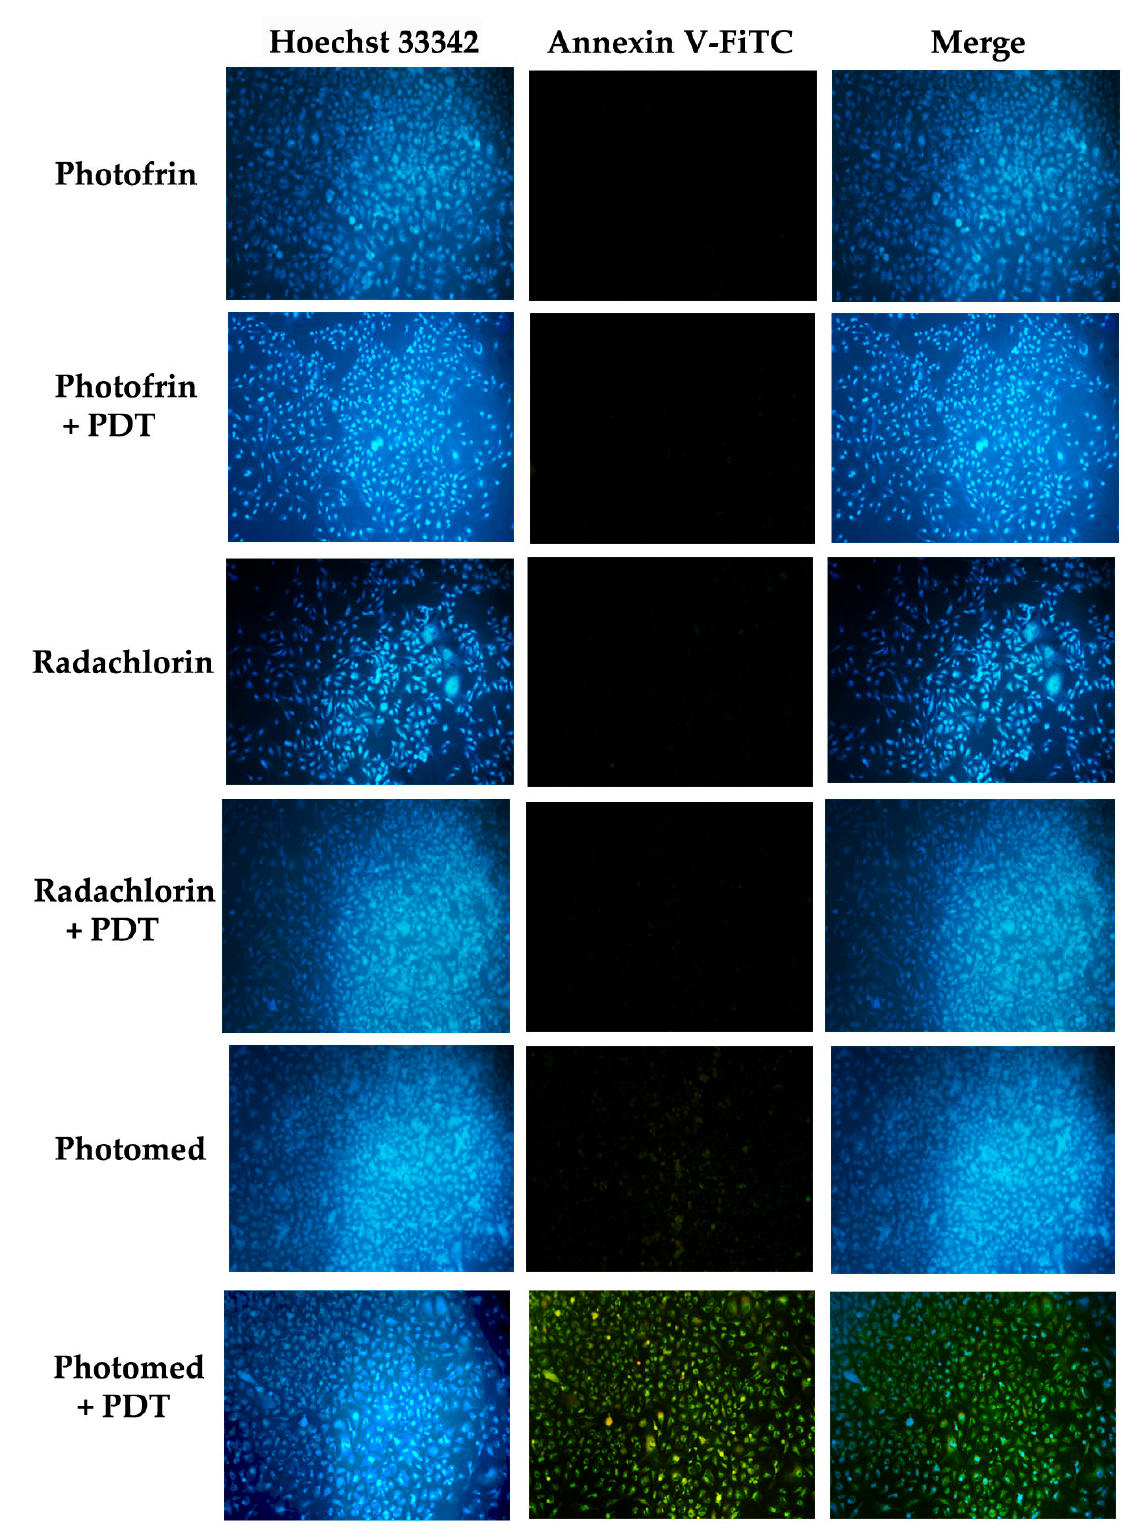
Figure 5. Fluorescence microscope analysis of apoptotic cells induced by PDT. Amounts of 0.5 µ M of Photofrin, Radachlorin and Photomed were treated for 24 h followed by no irradiation or light irradiation (5 mW/cm 2 , 400 s). Hoechst 33342 staining (blue, first column) indicating nuclei and Annexin V-FITC staining (green, second column) indicating apoptotic cells by PDT. Magnification ×100.